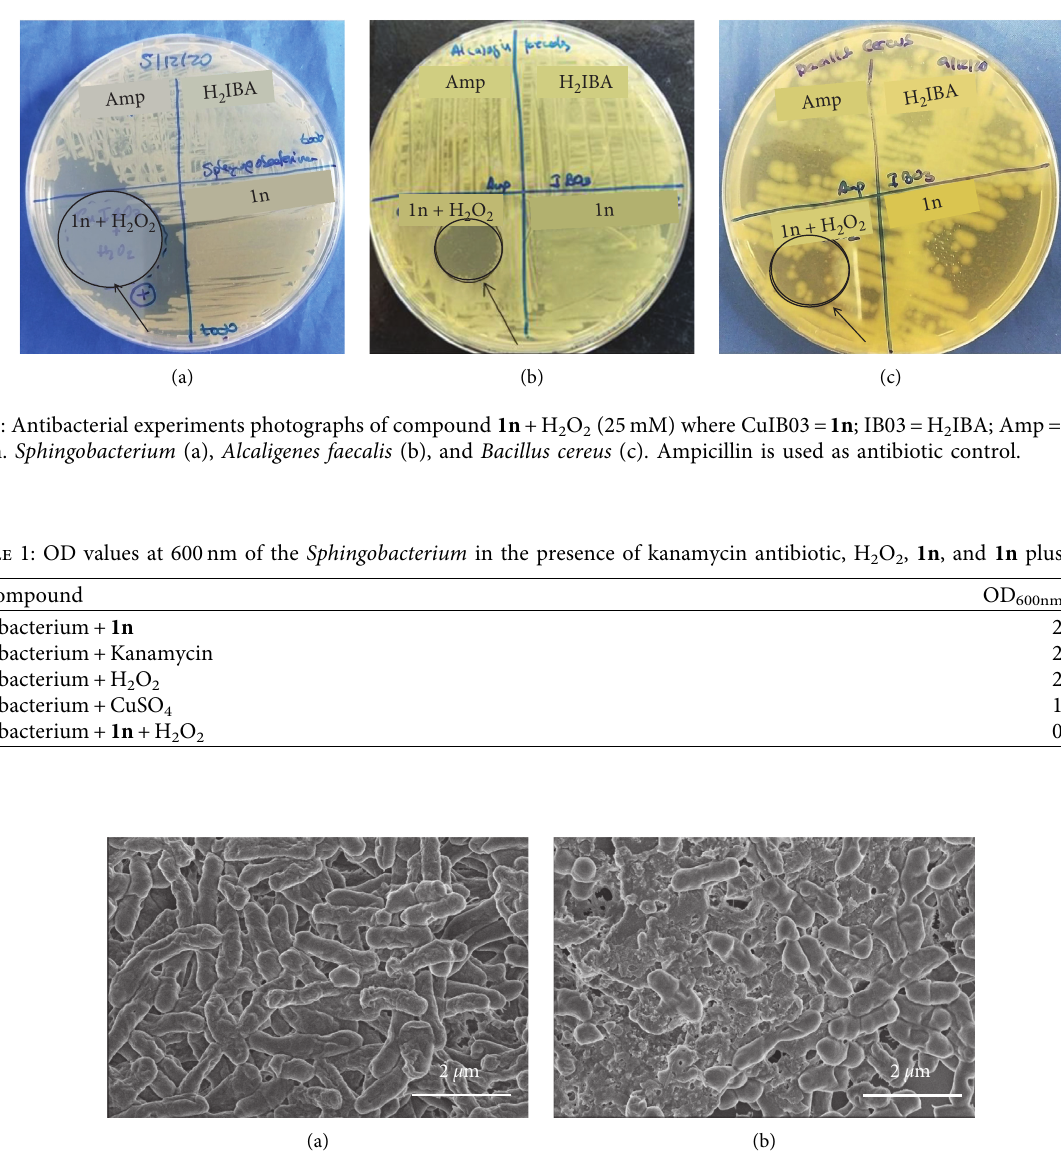
2 O 2 (30%) for 24h(b).